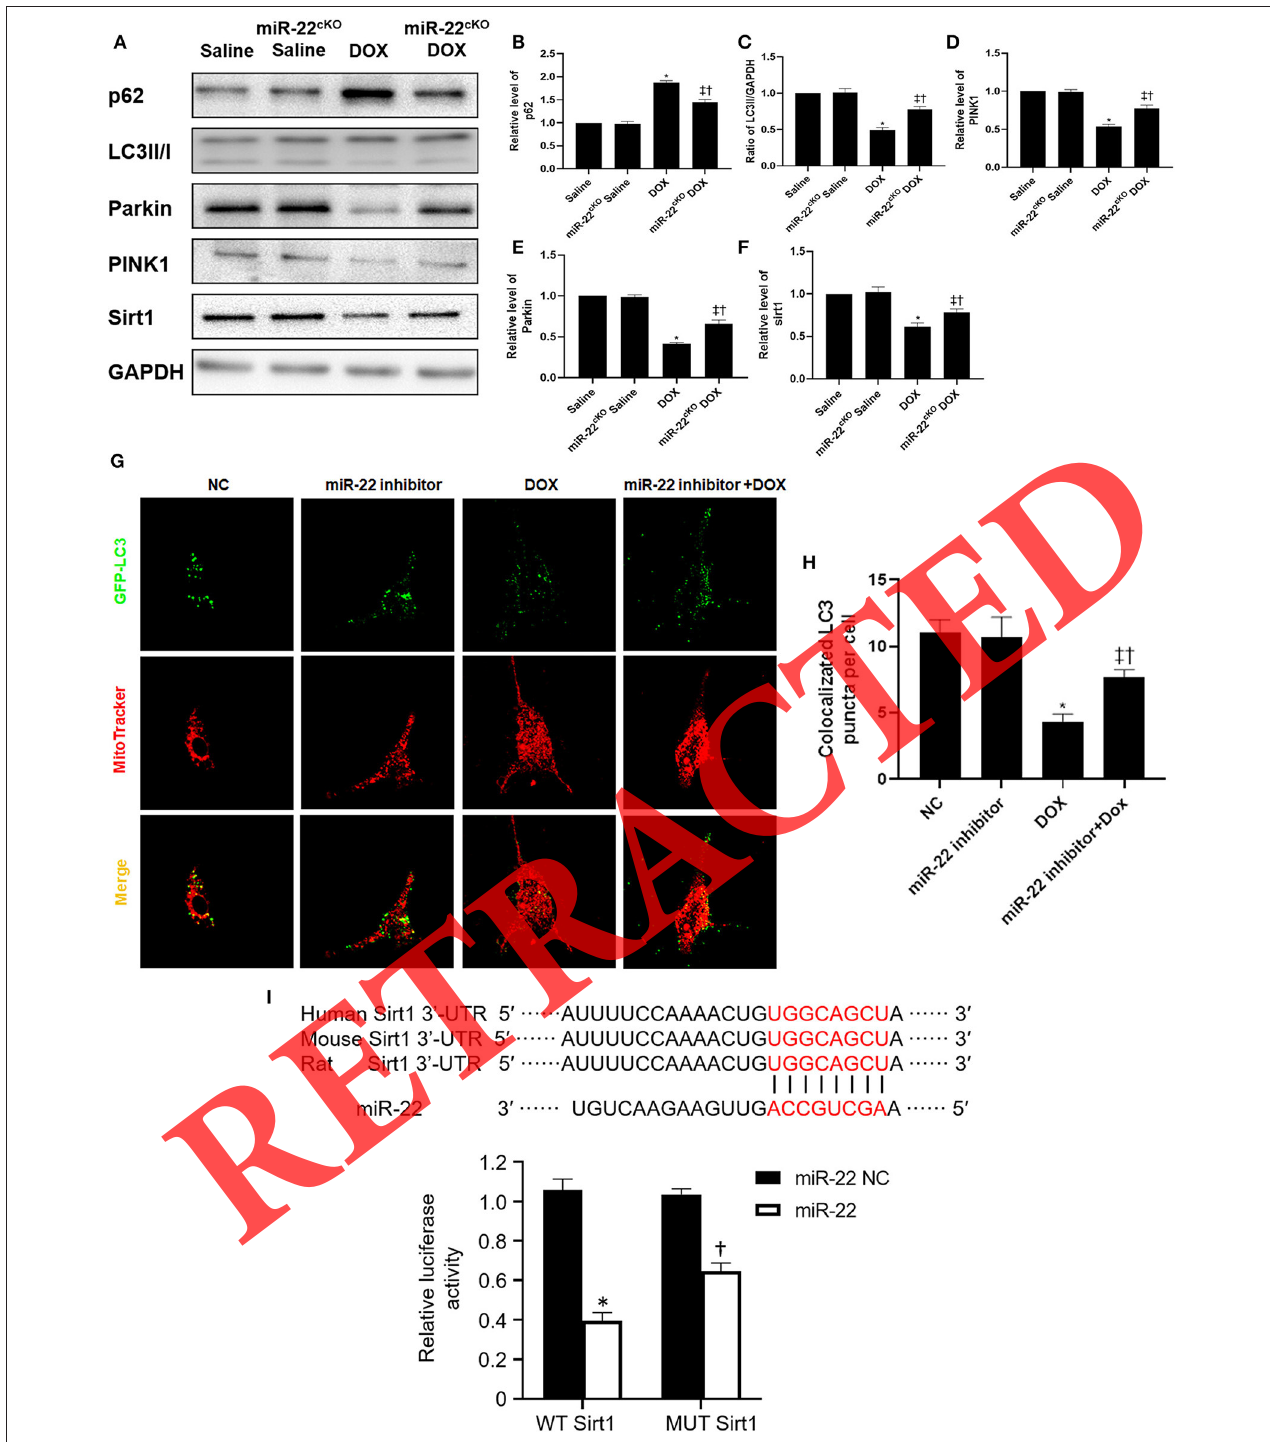
FIGURE 3 | Knocking out miR-22 improves the level of mitophagy in DOXIC. (A) Representative western blots, (B) relative p62 protein level ratio, (C) LC3II/GAPDH ratio, (D) relative PINK1 protein level ratio, (E) relative Parkin protein level ratio, (F) relative sirt1 protein level ratio, Data were expressed as mean ± SEM. * P < 0.05 vs. saline group, ‡ P < 0.05 vs. DOX group, † P < 0.05 vs. miR-22 cKO group. (G) Representative colocalization images of GFP-LC3 (green) and mitochondria (MitoTracker red), (H) Quantitative analysis of GFP-LC3 puncta per cell. * P < 0.05 vs. NC group, ‡ P < 0.05 vs. NC + DOX group, † P < 0.05 vs. miR-22 inhibitor group. Scale bars = 2 µ m. All the experiments were repeated three times. (I) Results of luciferase report. * P < 0.05 vs. NC group in sirt1 group, † P < 0.05 vs. NC group in MUT sirt1 group. All the experiments were repeated three times.